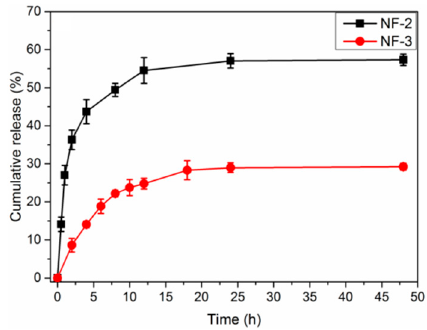
Figure 4. In vitro release profile of the VOO and HT from their respective PBA-CSNPs nanocapsules (NF-2 and NF-3) in PBS solution under physiological